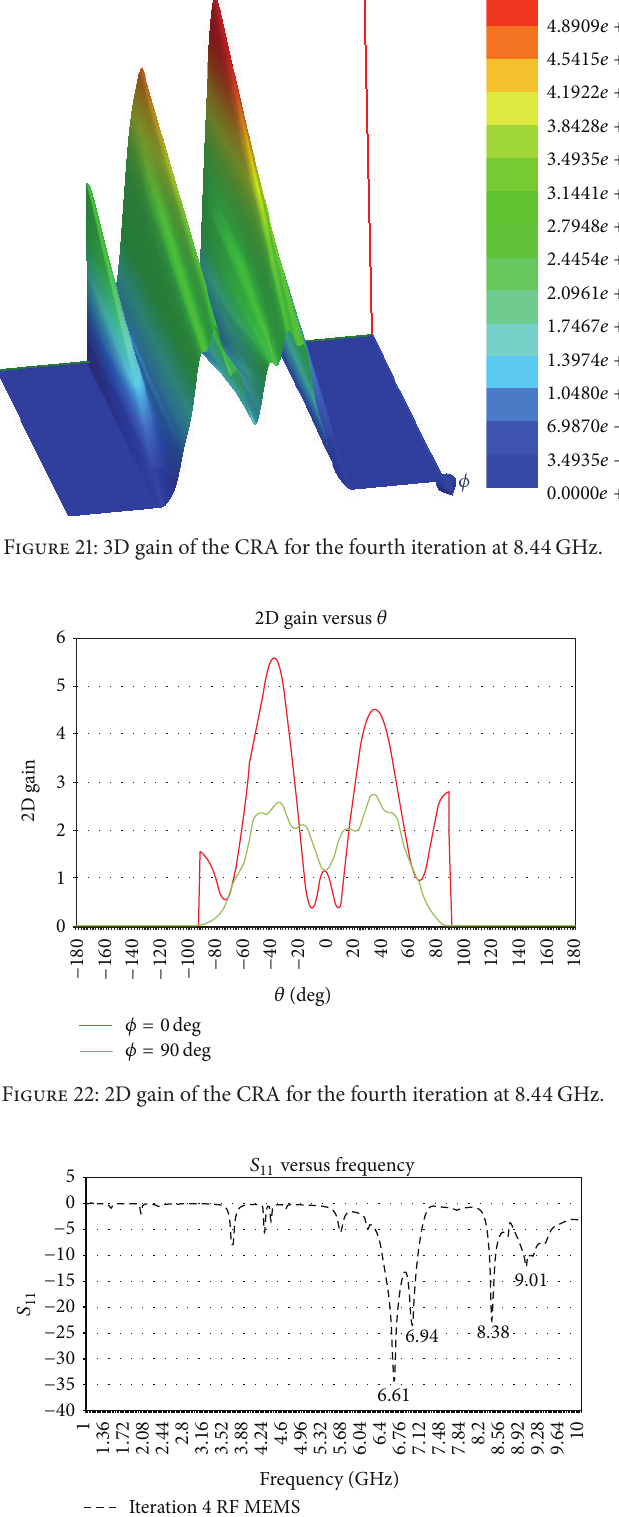
Figure 23: 𝑆 11 (RF MEMS switches) versus frequency